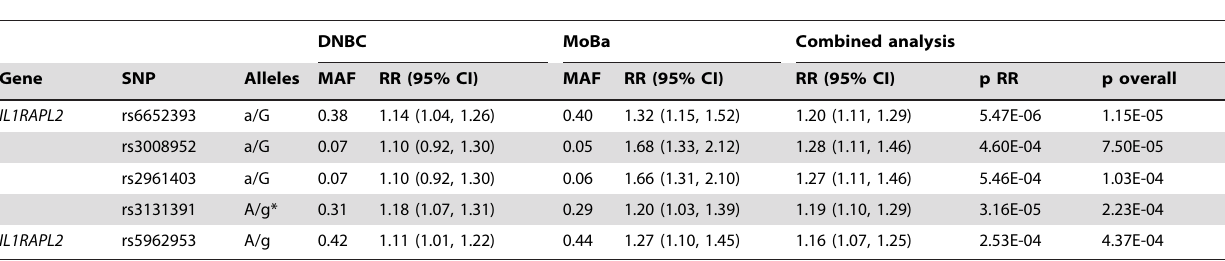
Table 5. Sex-stratified analysis,